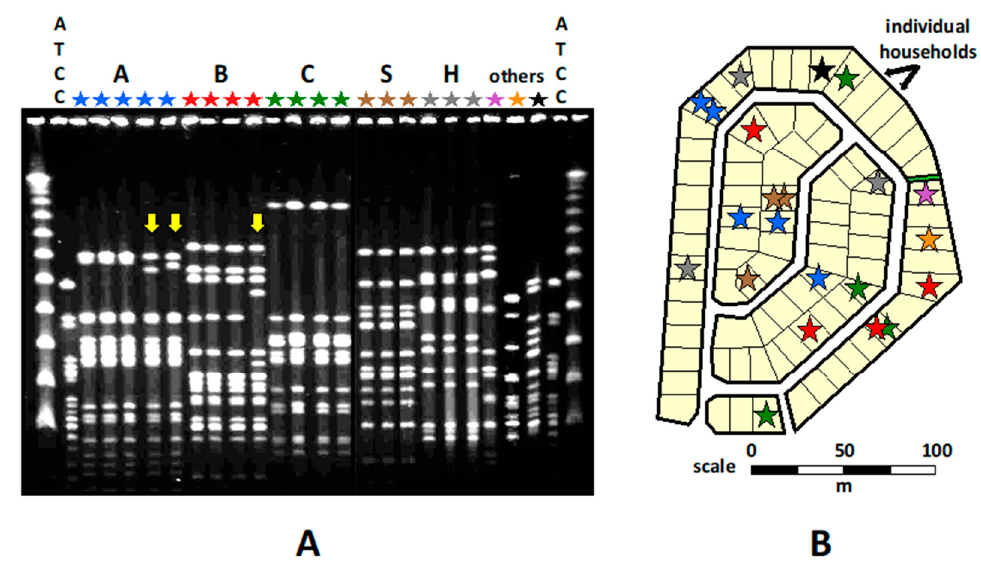
Figure 4. Kingella kingae clones carried in a Bedouin town neighborhood, as determined by PFGE with restriction enzyme Eag I. ( A ) Capital letters: individual clones; l: size marker; ATCC: ATCC 23,330 K. kingae strain; Yellow arrows: clones that exhibit differences in DNA band patterns. ( B ) Spatial distribution of the clones. Each star represents a positive pharyngeal culture, while the different colors represent distinct PFGE